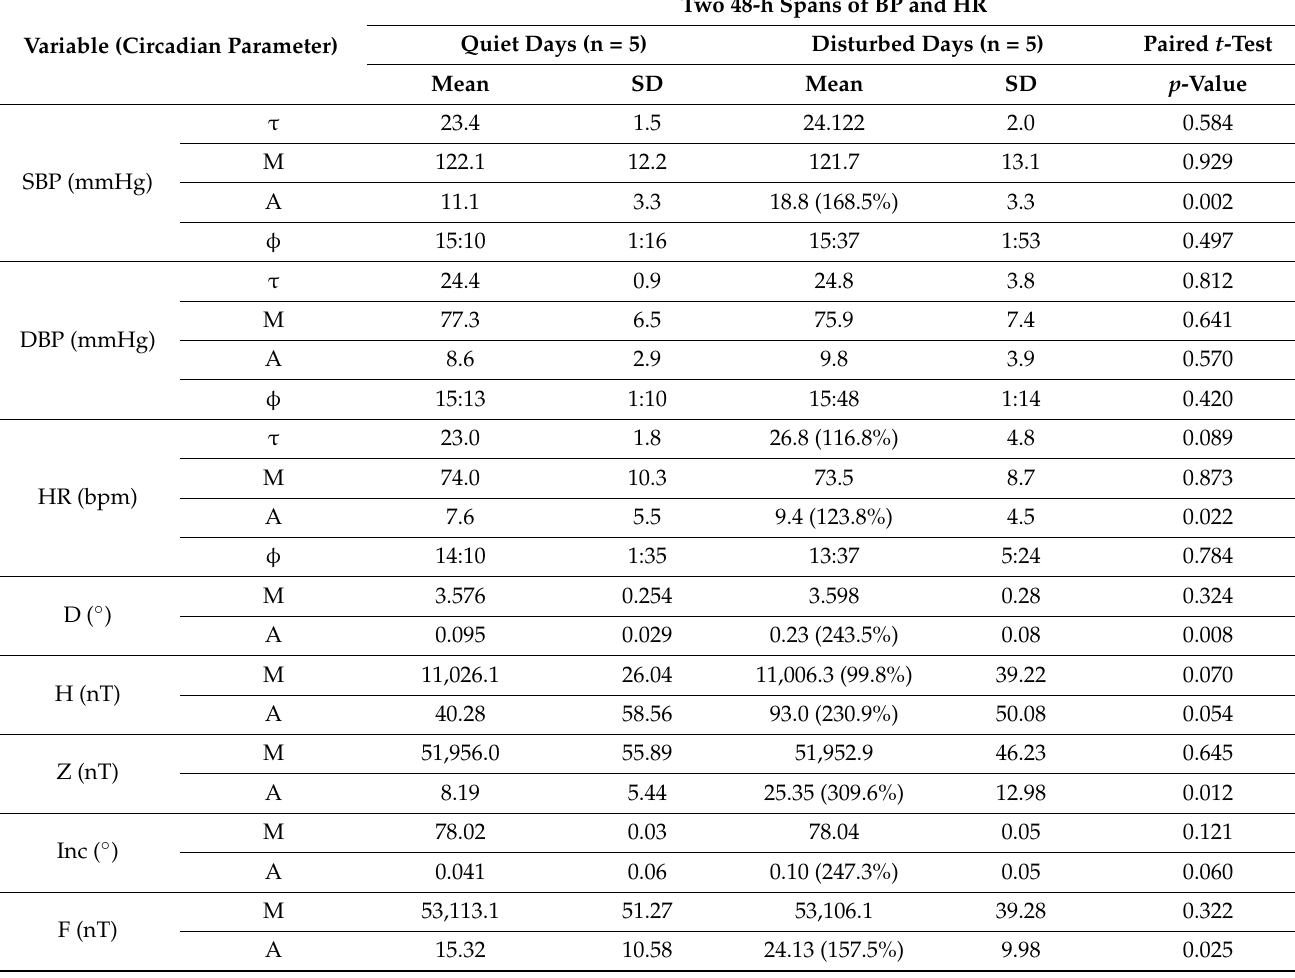
Table 2. Circadian characteristics of blood pressure (BP) and heart rate (HR) on days of moderate geomagnetic disturbances versus quiet days